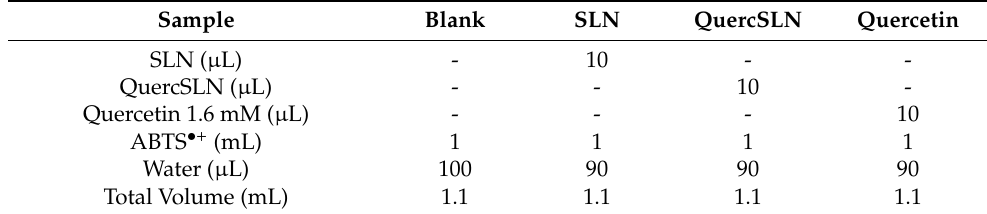
Table 5. Samples compositions for antioxidant activity